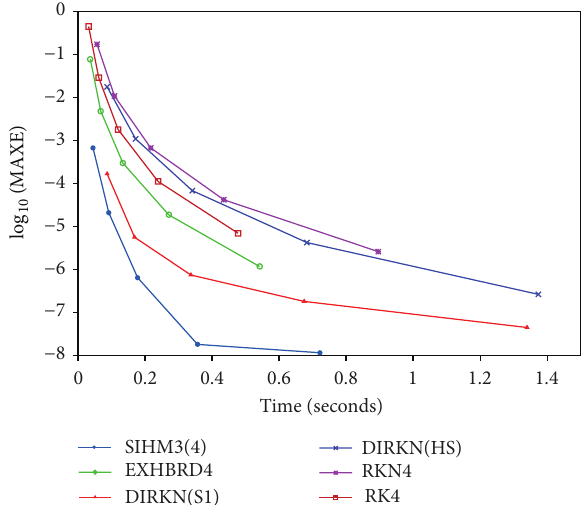
Figure 6: The efficiency curves for SIHM3 (4) method for Allen and Wing problem with ℎ = 0.125/2 𝑖 , 𝑖 = 2,...,6 .